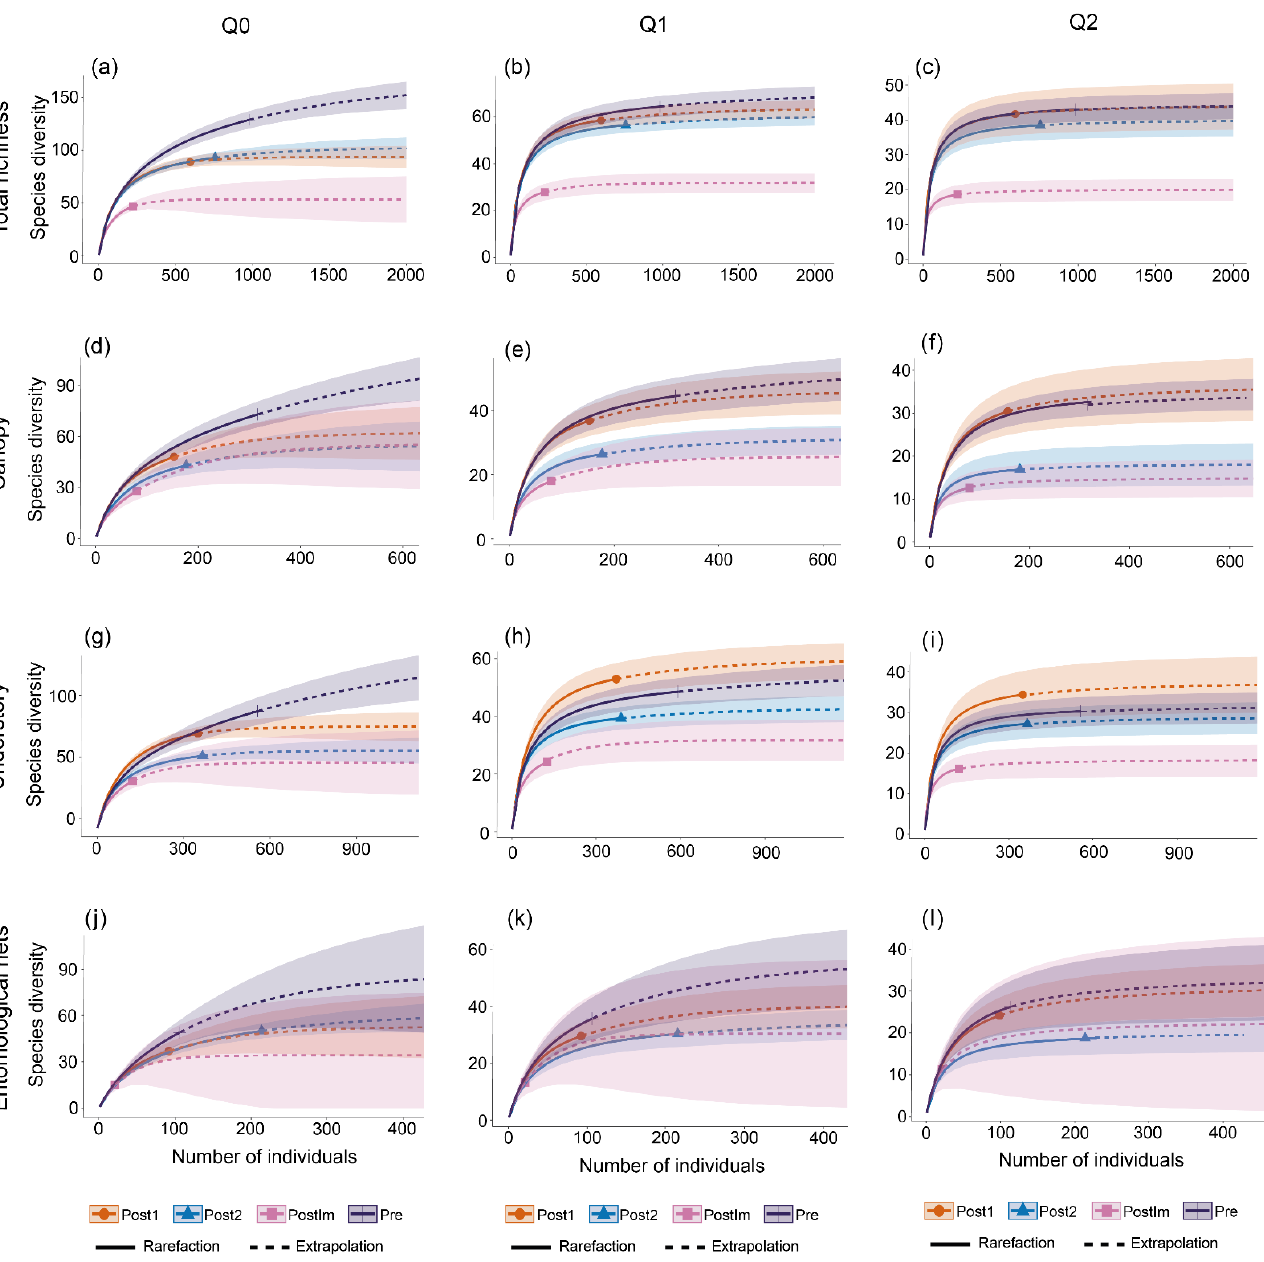
Figure 2. Individuals number-based rarefaction and extrapolation curves for butterfly communities before (Pre), immediately after (PostIm), one year after (Post1), and two years after (Post2) the filling of the Santo Antônio dam on the Madeira River in southwestern Amazonia, Brazil based on the thee sampling techniques ( a – c ), canopy traps ( d – f ), understory traps and ( g – i ) and entomological nets ( j – l ). 95% unconditional confidence intervals are shown by shading, based on bootstrapping with 1000 replications. Each curve is extrapolated to twice the maximum size of the largest sample.